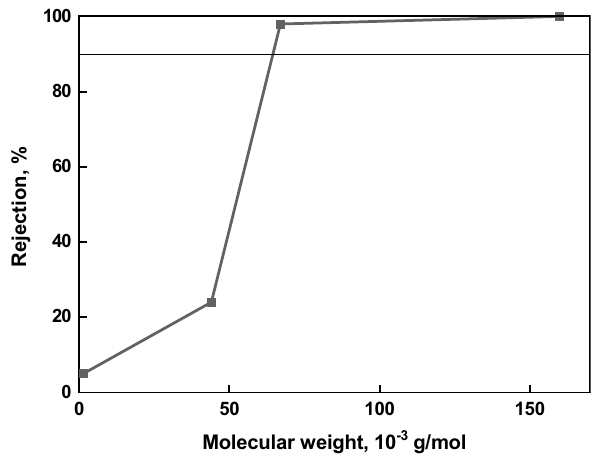
Figure 3. Dependence of protein rejection on the molecular weight for the P84 membrane prepared from a 15 wt% solution.